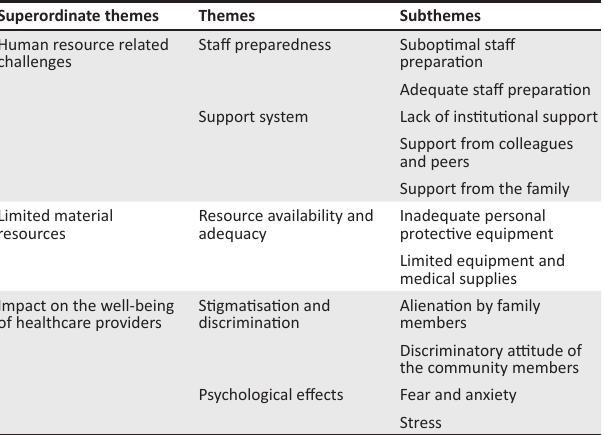
TABLE 3: Provision of care in the context of coronavirus disease